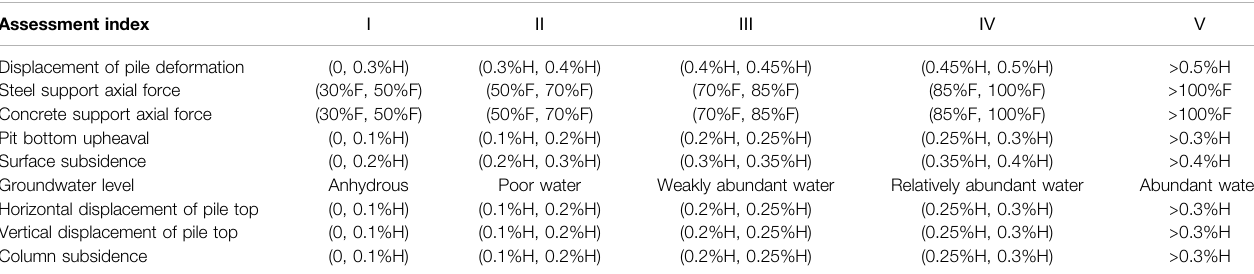
TABLE 1 | Classi fi cation of the safety levels of each assessment